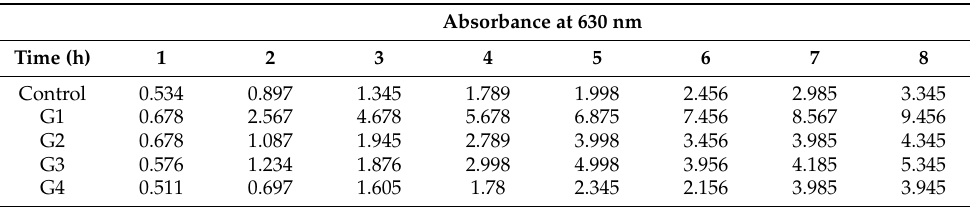
Table 4. Hemoglobin autoxidation rate of rabbits exposed to radiation by Gallium-68 injection, injected with 68 Ga protective treatment with Angelica archangelica (G2) and Ginkgo biloba (G3), as well as those with the combined dose as compared with the control (G4).